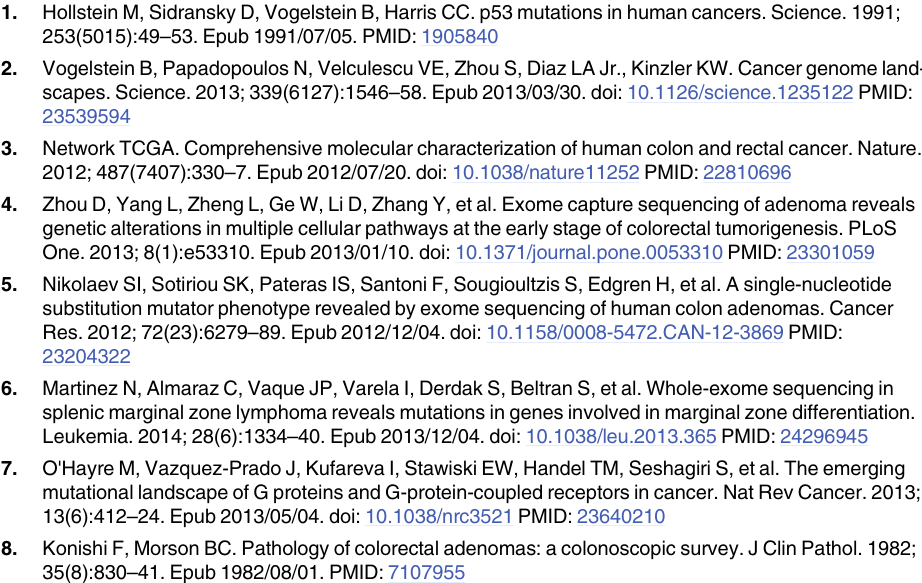
S2 Table. Validation panel. Wt Allele: Wild type nucleotide. Mut Allele: Mutated nucleotide. Ref. Reads: Number of reads of the Wt Allele. Mut reads: Number of reads of the Wt Allele. TumorA, C, G or T: Number of reads of each nucleotide. S3 Table. Oligonucleotides used for validation analysis. S4 Table. Nucleotide context in validated mutations. S5 Table. Unique mutations (SNVs) found in this study with potential to provoke amino acid changes. Ref_base: Wild type nucleotide. Mut_base: Mutated nucleotide. Reads_A, C, G or T: Number of reads of each nucleotide. In CpG: the nucleotide is located in a CpG island. Gene ID: Gene name. Transcript ID: Transcript name. c.Annot: Mutation in the cDNA. pAn- not: Mutations in protein. Interpretation: Mutations